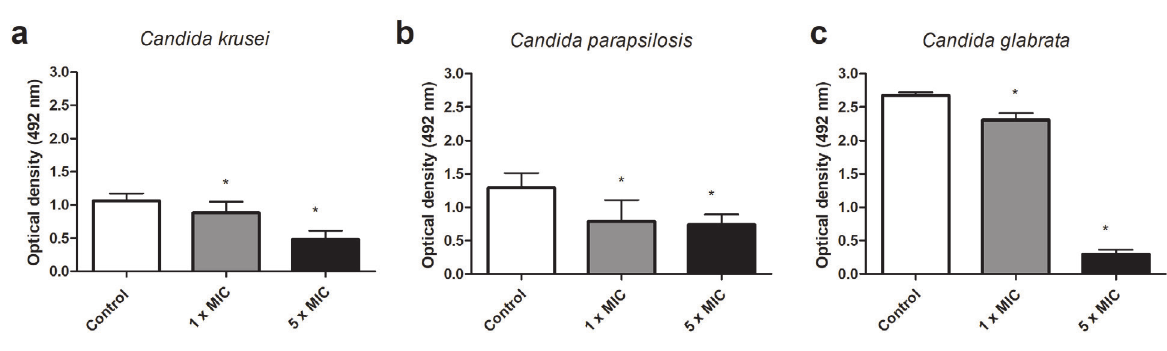
Figure 4. Metabolic activity of biofilms of non- albicans Candida species after treatment with verapamil at the MIC and five times the MIC. (a) C. krusei ; (b) C. parapsilosis ; (c) C. glabrata. Asterisks represent statistically significant differences with untreated biofilm (control) as shown by ANOVA (p < 0.05). Error bars represent the SEM (standard error of the mean) of 10 biological